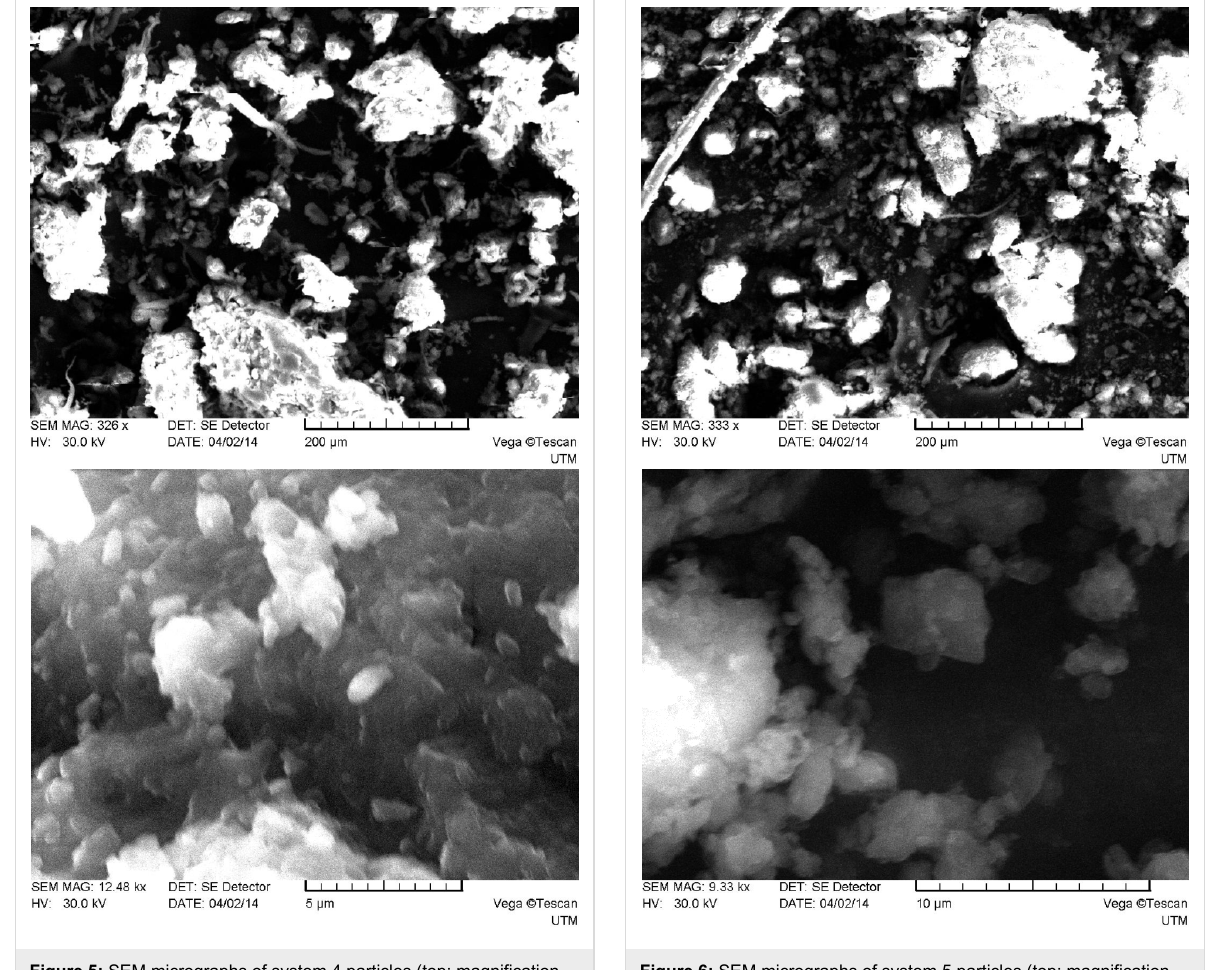
the band characteristic for OH groups: system 3 – 3278 cm − 1 , system 4 – 3277 cm − 1 , system 5 – 3269 cm − 1 , and changes in